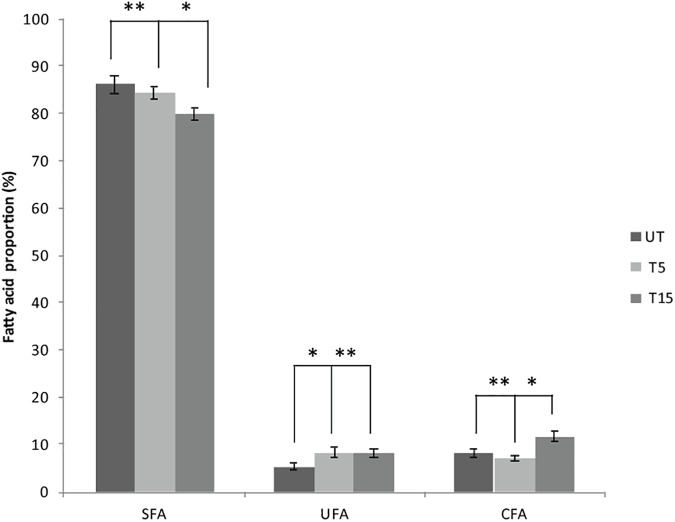
Effect of UVc treatment on the membrane FA composition of Pseudomonas swarmer cells. SFA: saturated fatty acids, UFA: unsaturated fatty acids, CFA: syclopropane fatty acids, UT: untreated, T5: 5 min of treatment, T15: 15 min of treatment. (∗) shows significant difference (P < 0.05) and (∗∗) shows no significant difference.